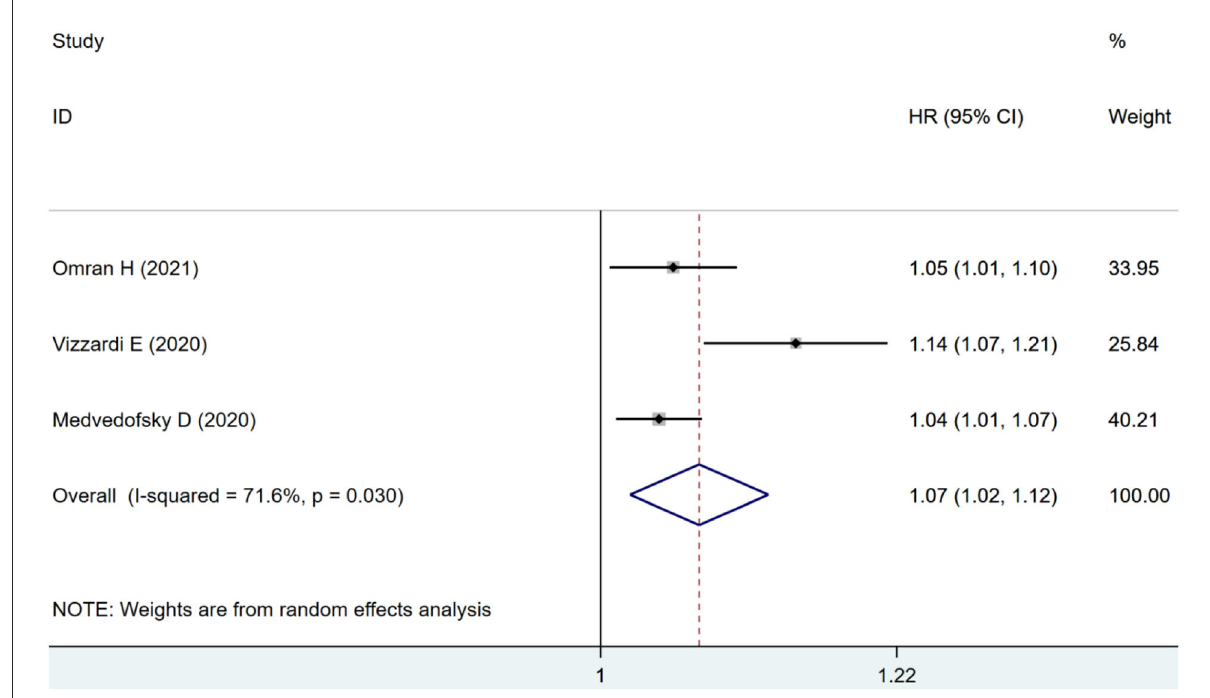
FIGURE6 Forest plot demonstrating the association between RVLS and ACM alone in patients with AS undergoing